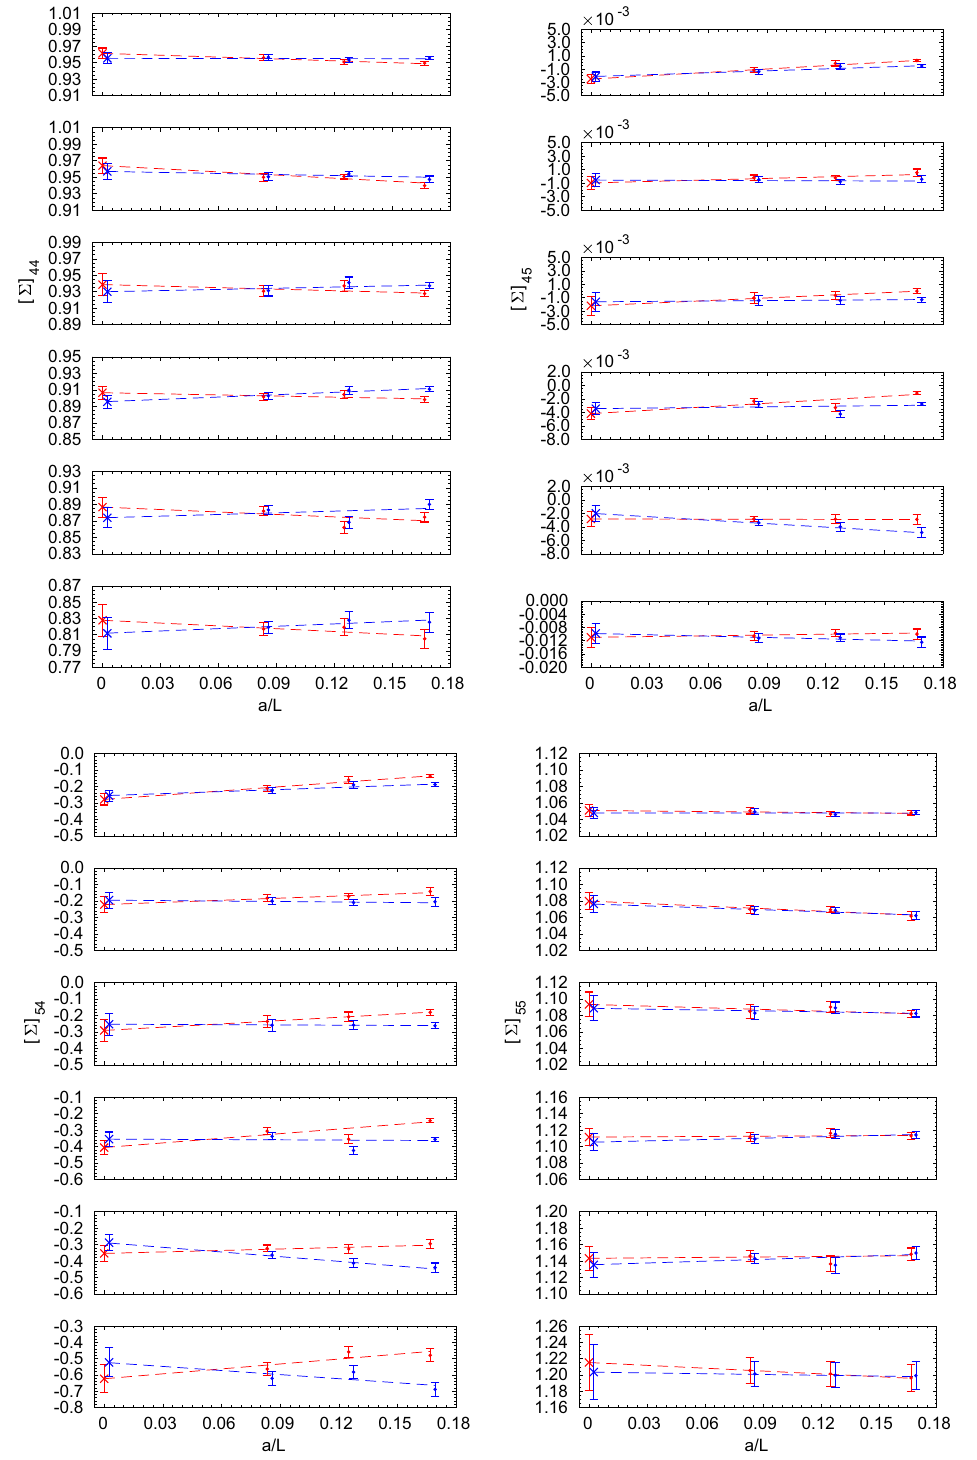
+ ( u , a / L ) inblue,oftheoperatorbasis { Q +